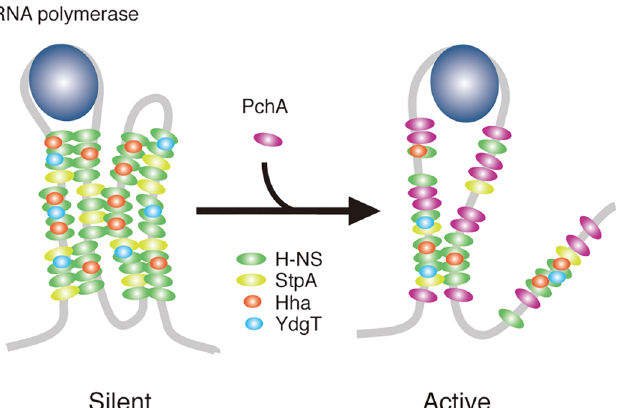
complex. In the silencing complex, DNA is folded through bridging between the proteins, and RNA polymerase might be trapped (silent). Competitive binding of Pch removes some H-NS and other